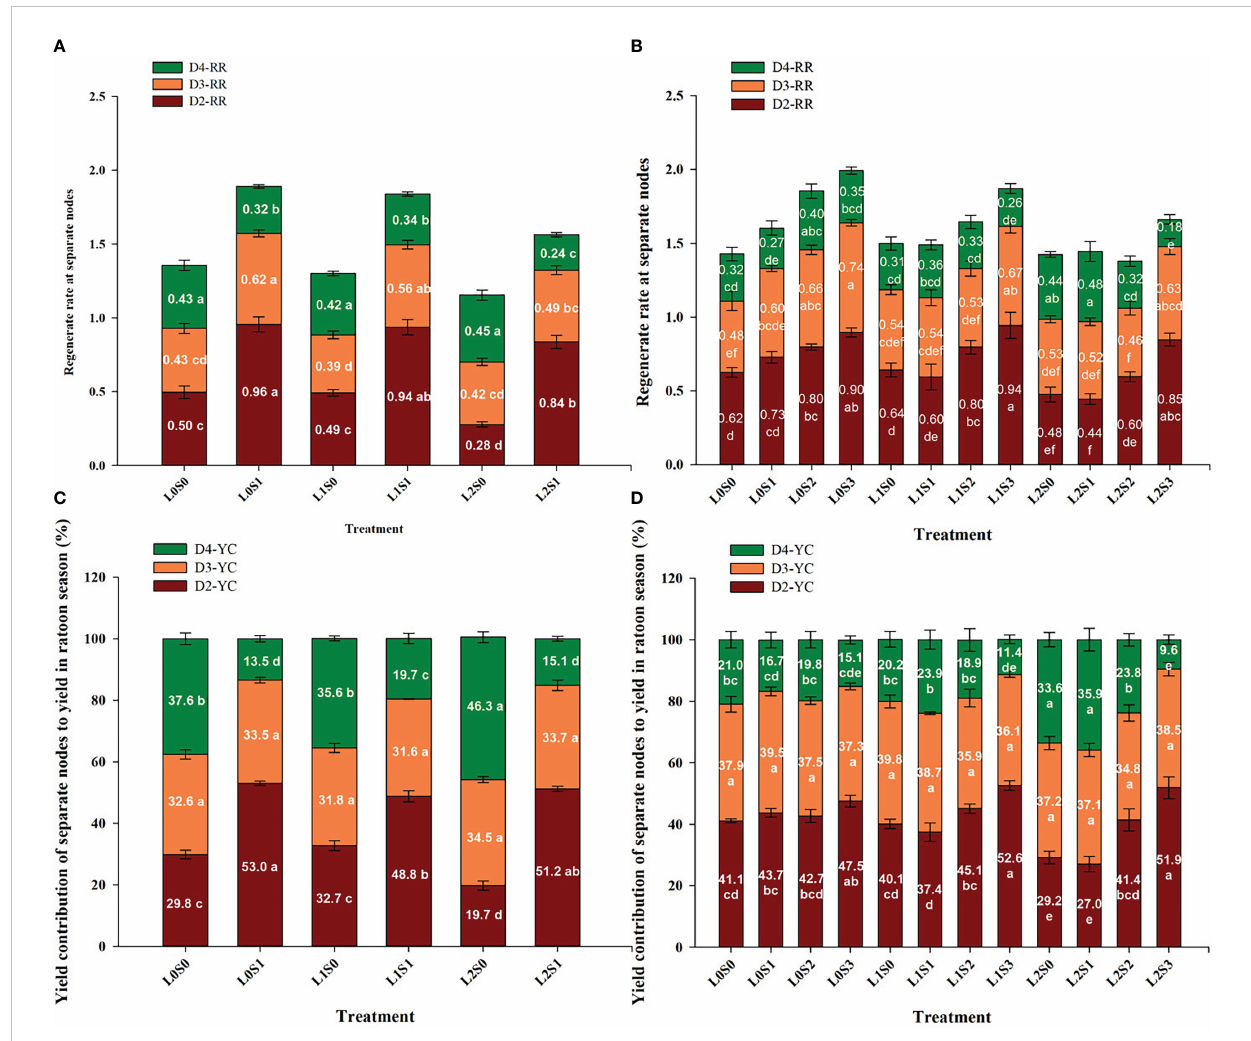
FIGURE 4 Effects of leaf cutting and spikelets thinning on regeneration rate (A, B) at separate nodes and yield contributions of separate node to total grain yield in ratoon crop (C, D) in 2018 (A, C) and 2019 (B, D) . L0 represent the treatment of no leaf-cutting; L1 represent the treatment of cutting top of one leaf; L2 represent the treatment of cutting top of three leaves; S0, S1, S2 and S3 represent the treatment of thinning 0, 1/4, 1/2 and 3/4 spikelets, respectively. D2, D3 and D4 represent the second, third and lower than third nodes from the top, respectively. D2-YC, D3-YC and D4-YC represent the yield contribution of D2, D3 and D4 node to total grain yield in ratoon crop, respectively; D2-RR, D3-RR and D4-RR represent the regeneration rate in D2, D3 and D4 nodes, respectively. The value in each stacking bar represents the mean value of yield contribution or regeneration rate at separate nodes. The different lower-case letters on the same color column showed signi fi cant differences at the 0.05